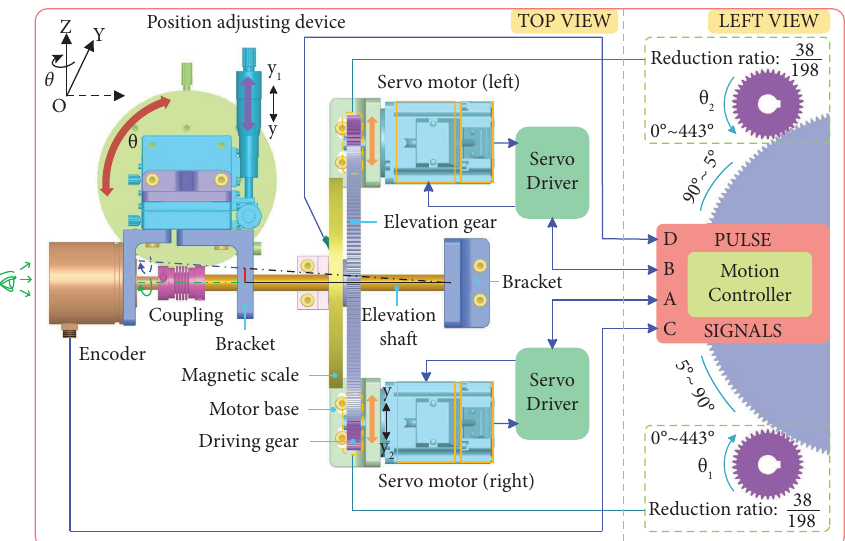
Figure 1: Te measurement principle of the error of the elevation